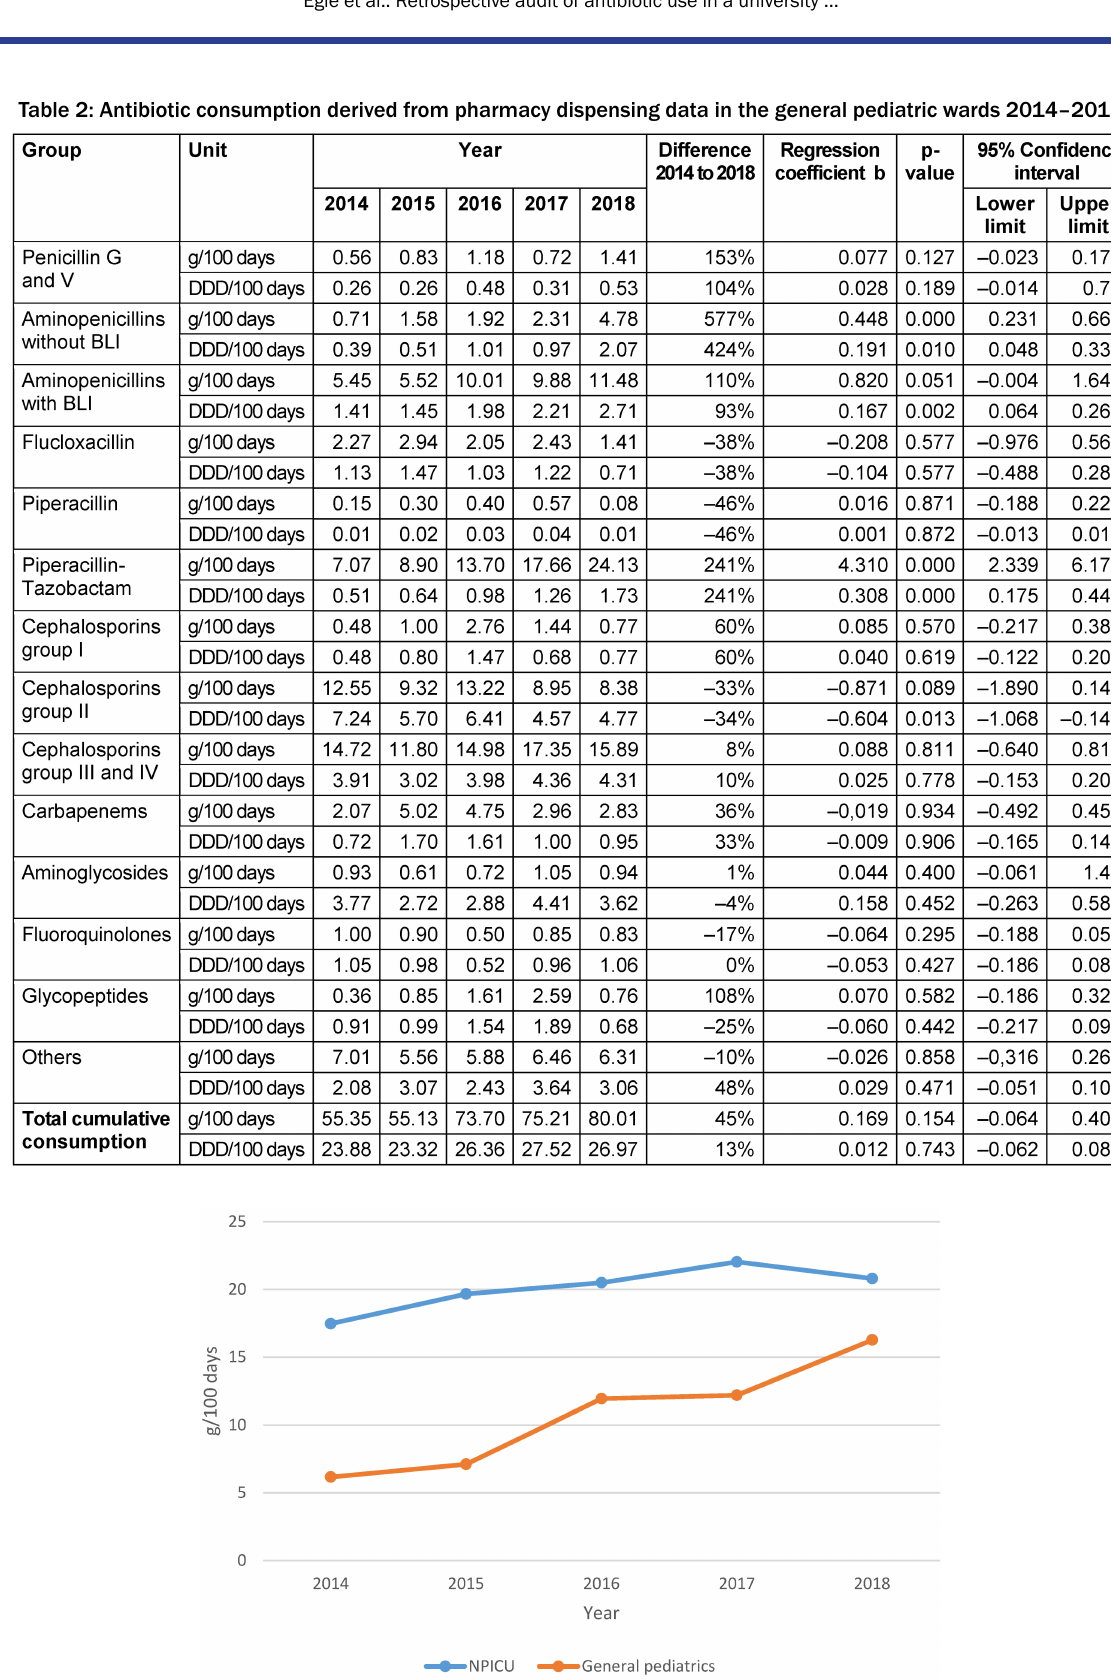
Figure 2: Total consumption of